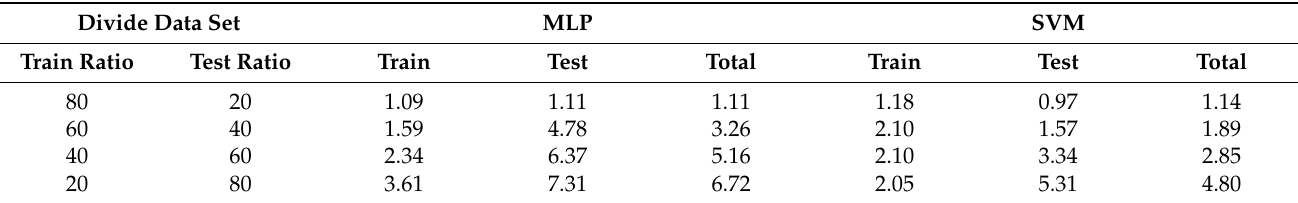
Table 1. The results of generalisation capability MLP and SVM models based on RMSE.